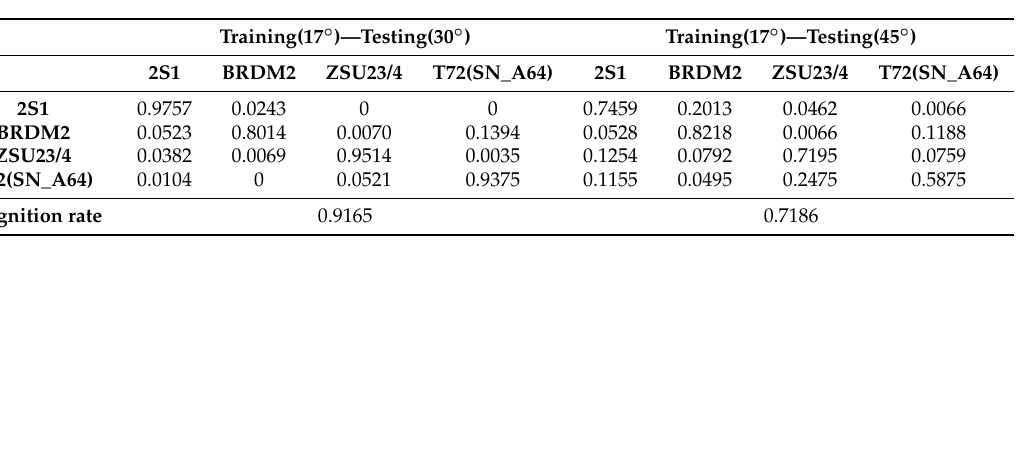
Table 8. The result of SDDLSR based on the raw intensity image under